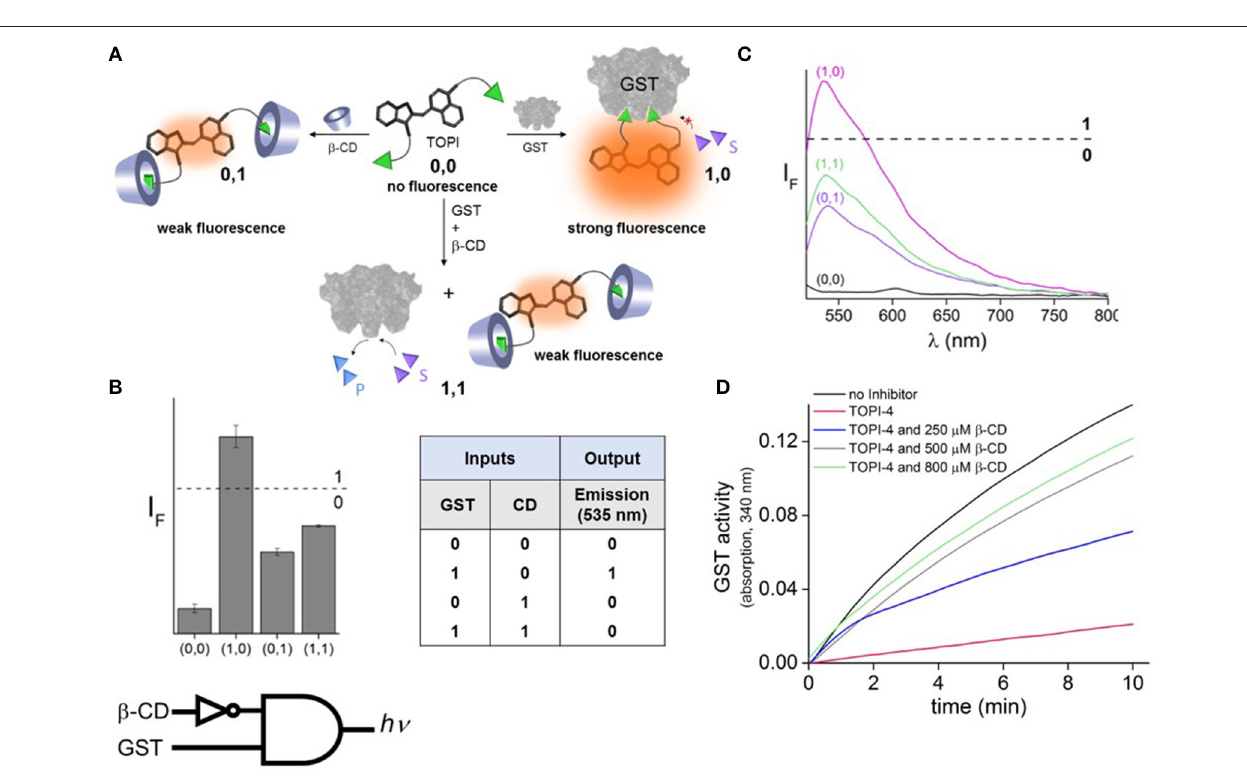
FIGURE 2 | (A) Schematic illustration showing how the binding of TOPI-4 to GST and/or β -CD inputs affects the catalytic activity of GST and the emission of the probe, which results in an optical INHIBIT gate function. S and P correspond to the substrate and product, respectively. (B) The corresponding bar plot and truth table. The results are expressed as the mean values ± std. deviation of the triplicate measurements. (C) The fluorescence response of TOPI-4 (100nM) to different combinations of the GST (90nM) and/or β -CD (1mM) inputs. (D) Enzymatic activity of GST (20nM) in the absence and presence of TOPI-4 (500nM) and with increasing concentrations of β -CD. λ ex / λ em =